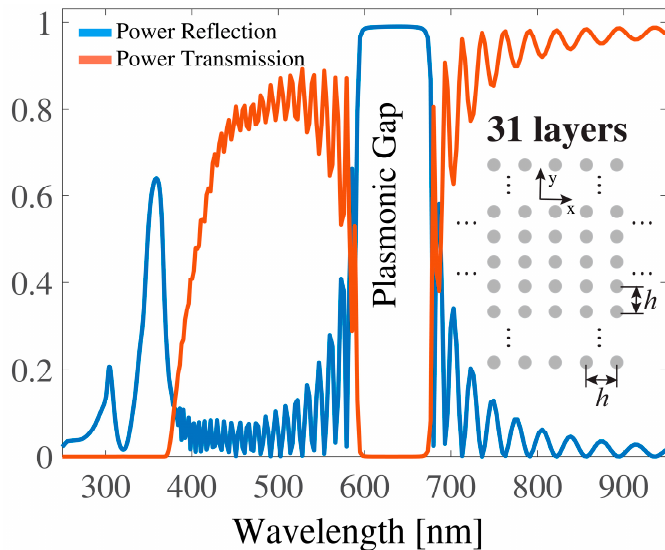
Figure 1. Power reflection (blue line) and power transmission (red line) of a 31-layered plasmonic crystal formed by the corresponding periodical arrangement of cylindrical Ag nanocylinders. Period of the grating was equal to h = 300 nm and radius of the nanocylinder amounts to r = 40 nm. Excitation was provided by an impinging H-polarized plane wave ( H z , E x , E y ) with normal incidence (along the positive y -axis).